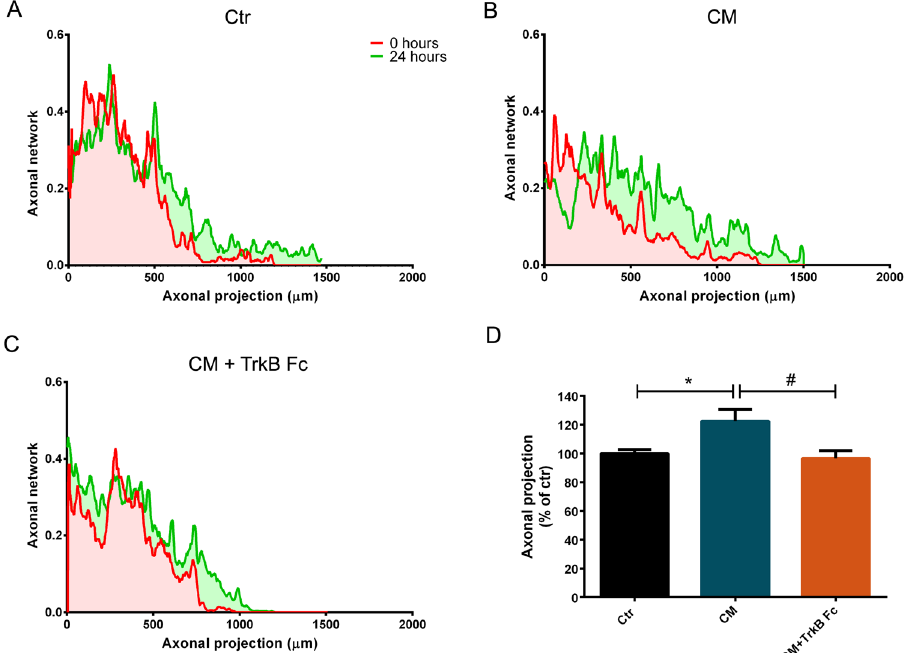
Figure 6. BDNF is the molecule responsible for CM-induced axonal elongation in distal cortical axons. ( A – C ) Quantification of axonal outgrowth with the MATLAB script AxoFluidic. Profile along the xx axis of the microfluidic device showing the area occupied by the axons at 0 hours (clear red area) and at 24 hours (clear green area). Red line represents axonal projection at 0 hours and the green line represents axonal projection at 24 hours. ( D ) Quantification of axonal projections outgrowth between 0 and 24 hours. Distal axons treated with CM for 24 hours present more pronounced elongation than control or CM-lacking BDNF axons. Bars represent the mean ± SEM of 6 microfluidic chambers randomly selected of 3 independent experiments. * Represents p = 0.0346 by one-way ANOVA analysis of variance using Tukey post test when Ctr is compared to CM; # represents p = 0.0145 by one-way ANOVA analysis of variance using Tukey post test when CM is compared to CM + TrkB